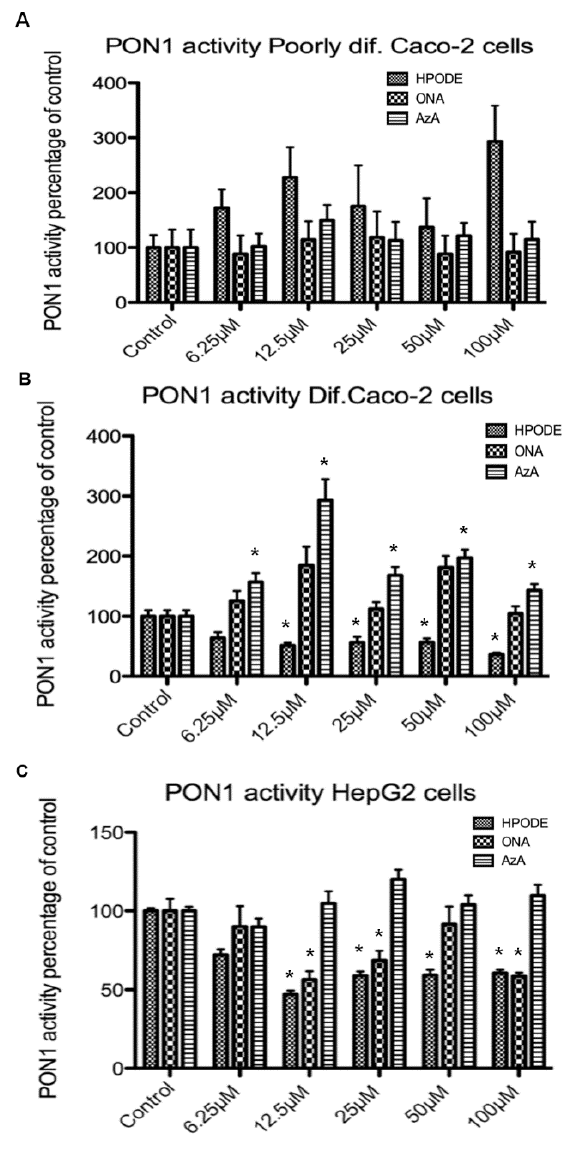
Figure 6. PON1 activity following treatment with 13-HPODE, 9-ONA and AzA: ( A ) poorly differentiated Caco-2 cells; ( B ) fully differentiated Caco-2 cells; ( C ) HepG2 cells ( n = 9/group, * p < 0.05).